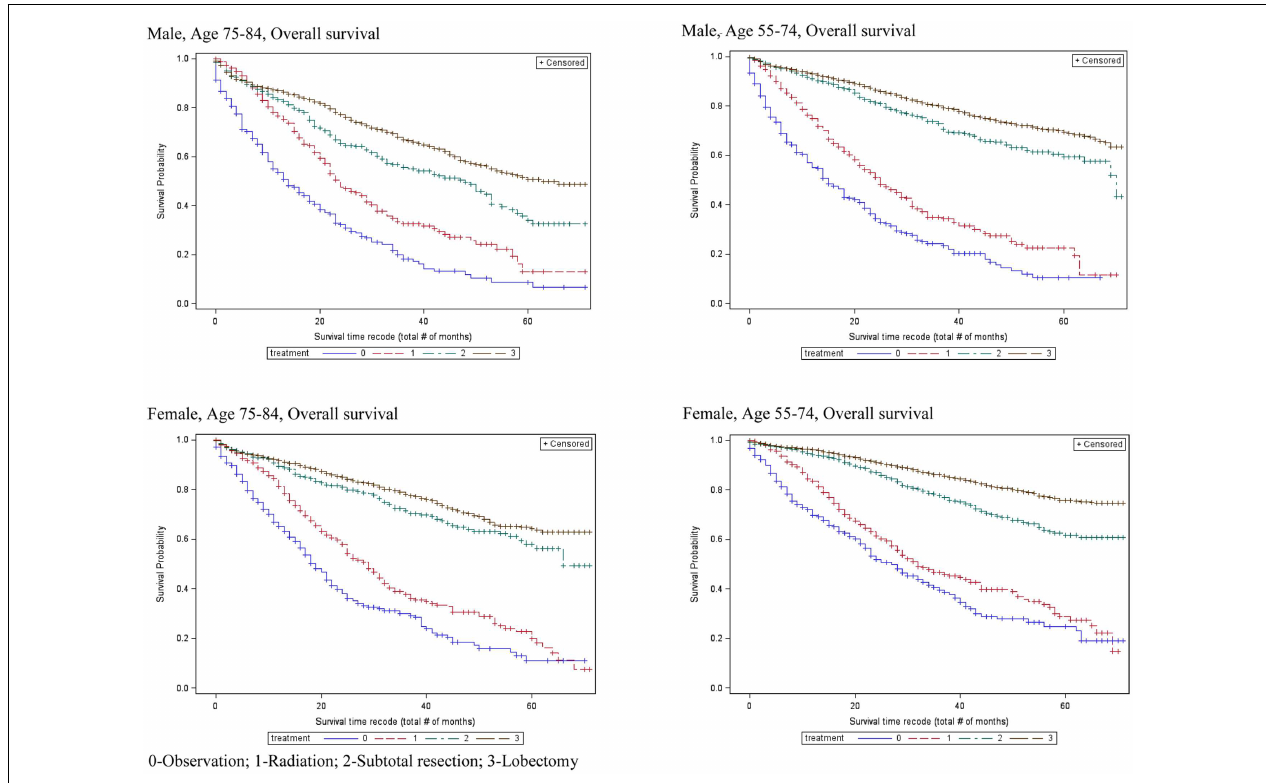
FIGURE 3 | Overall survival curves for patients by age groups .